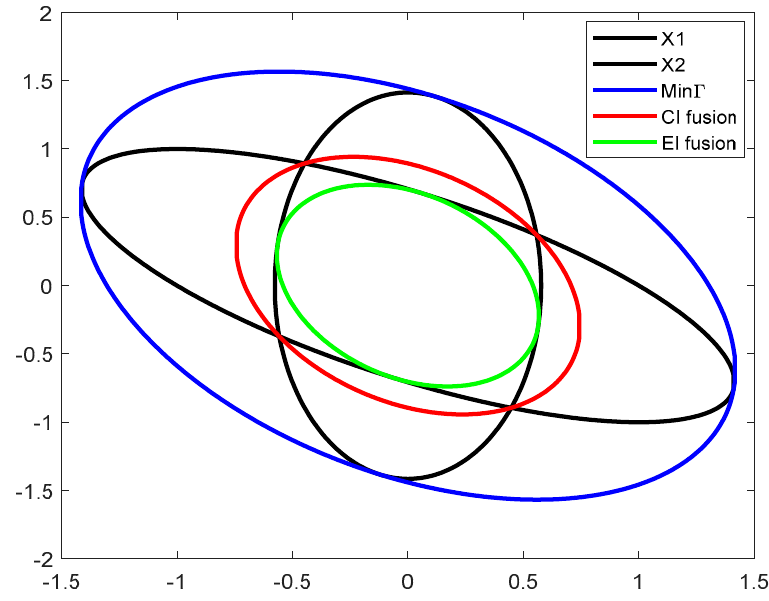
Figure 2. Results of the minimizing Γ , CI fusion, and EI fusion methods for two state ellipsoid esti-